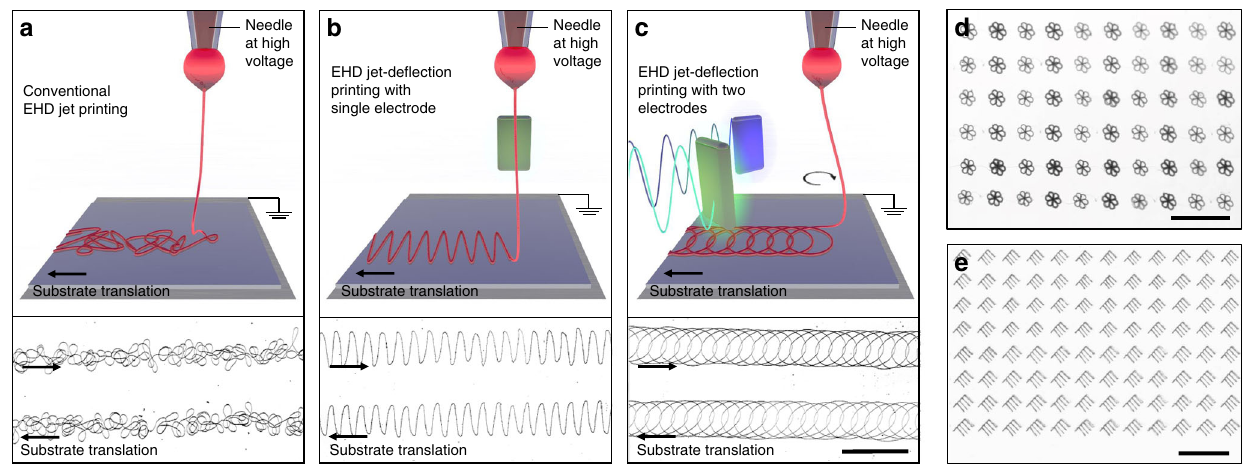
Fig. 3 Printing 2D patterns. a – c Schematics (top panels) and optical photographs of the experimental PEO-PEDOT:PSS patterns printed as the substrate is continuously moved in a straight line (bottom): a fi ber buckling obtained with no jet de fl ection; b sawtooth pattern obtained using 1D jet de fl ection in an axis normal to the translation of the mechanical stage; and c circular pattern obtained using 2D jet de fl ection. All optical images have the same scale of 250 µ m. d, e Optical photographs of more complex 2D patterns printed using two jet-de fl ecting electrodes to de fi ne the pattern and the mechanical stage to translate the substrate between printing events. A 4.7 wt% PEO ink containing Ag NPs was used to print these patterns. Scale bars ( d, e ): 1 mm.